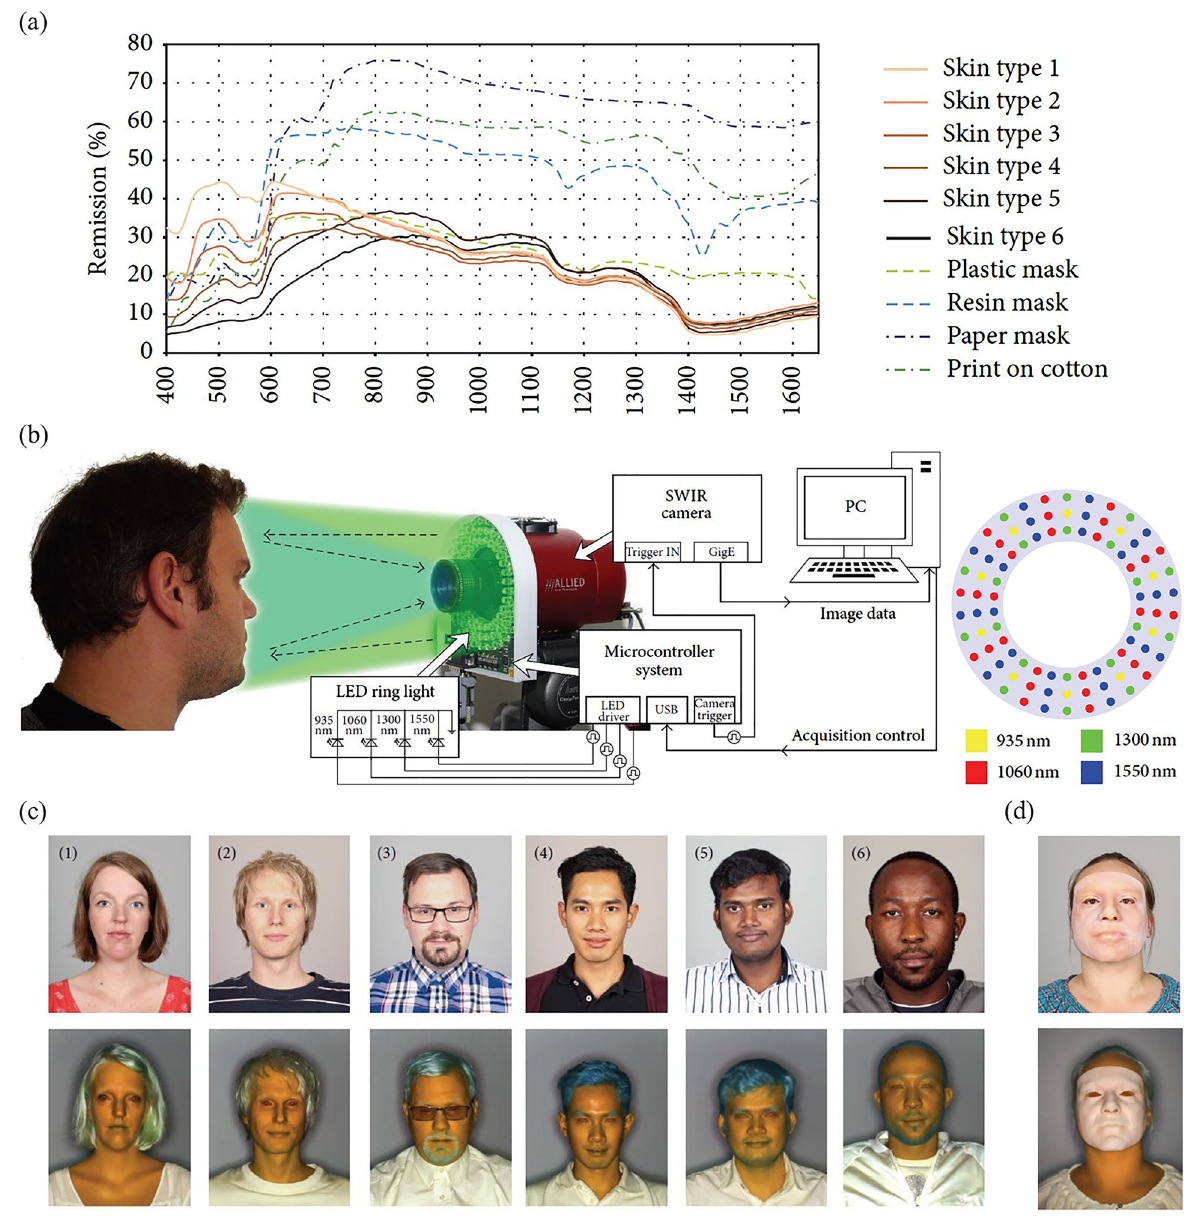
Figure 4: Multispectral imaging applied for facial recognition showing advantage of anti-spoofing. (a) Remission spectrum of different skin types and spoofing mask materials from visible to NIR wavelength. (b) Schematic of multispectral facialrecognitionsystemsetup,includingLEDarraysatfourdifferentwavelengths(935,1060,1300and1550nm)aslightsource(rightpanel), and a short wavelength infrared (SWIR) camera for image capture. (c) Facial images captured with visible ( fi rst row) and SWIR (second row) wavelengths of different skin types. SWIR images are insensitive to different skin tones. (d) Facial images with a printed mask in visible (top) and SWIR (bottom) wavelength. The mask material can be clearly distinguished in SWIR image. (a) – (d) are adapted with permission from the study by Steiner et al. [23]. Licensed under a Creative Commons